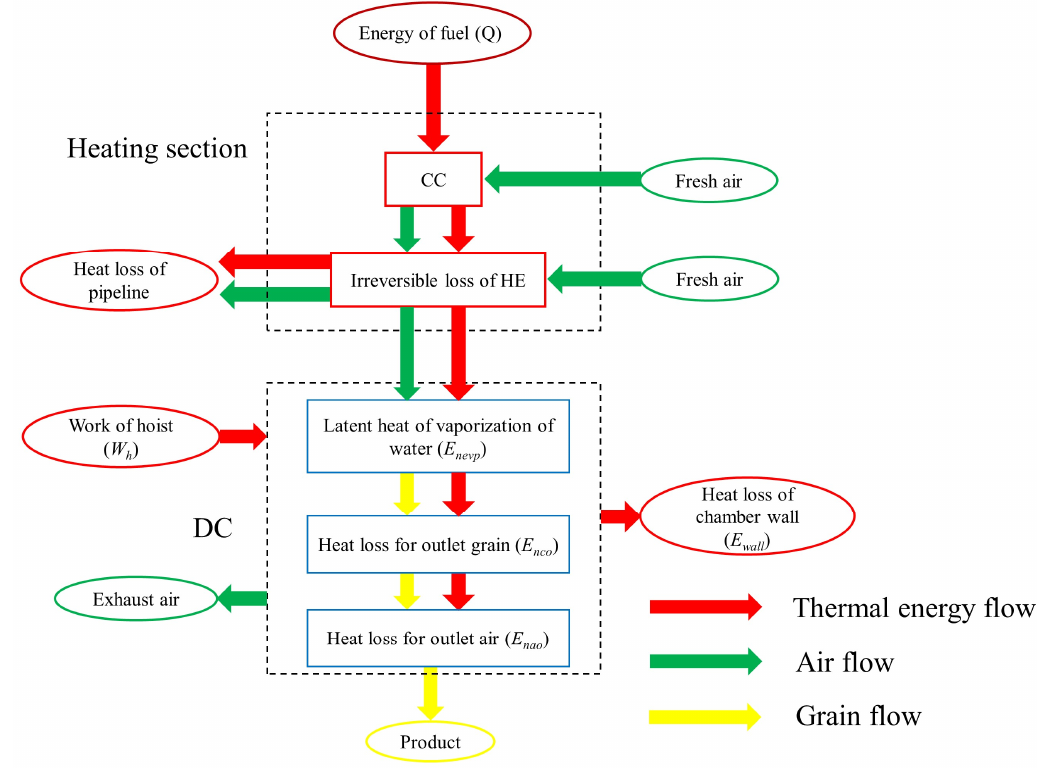
Figure 4. Energy flow in hot air-drying system for corn.